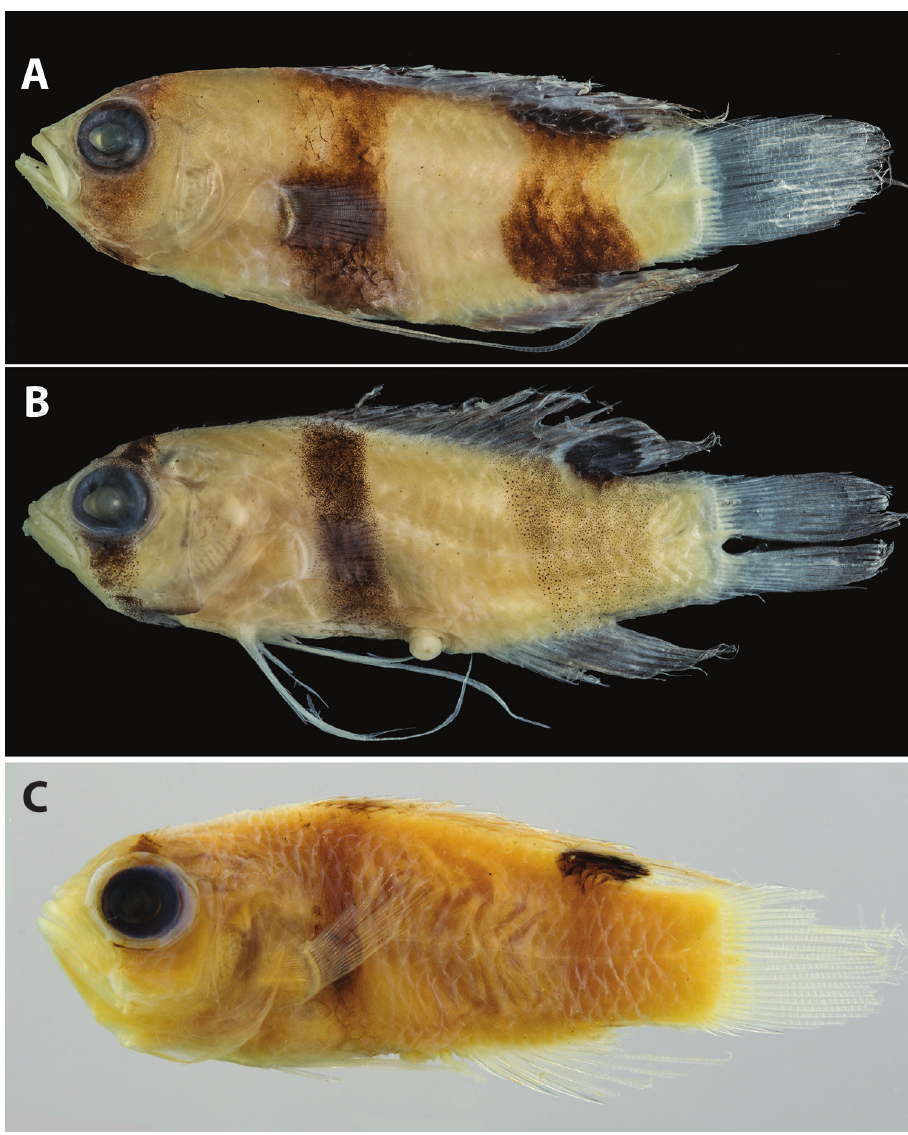
Figure 5. Preserved specimens of A Lipogramma levinsoni sp. n., holotype, USNM 406139, 28.3 mm SL B Lipogramma haberi sp. n., holotype, USNM 422679, 40.1 mm SL C L. evides , paratype, ANSP 134330, 30.5 mm SL Photos A and B by Sandra Raredon, C by Mark